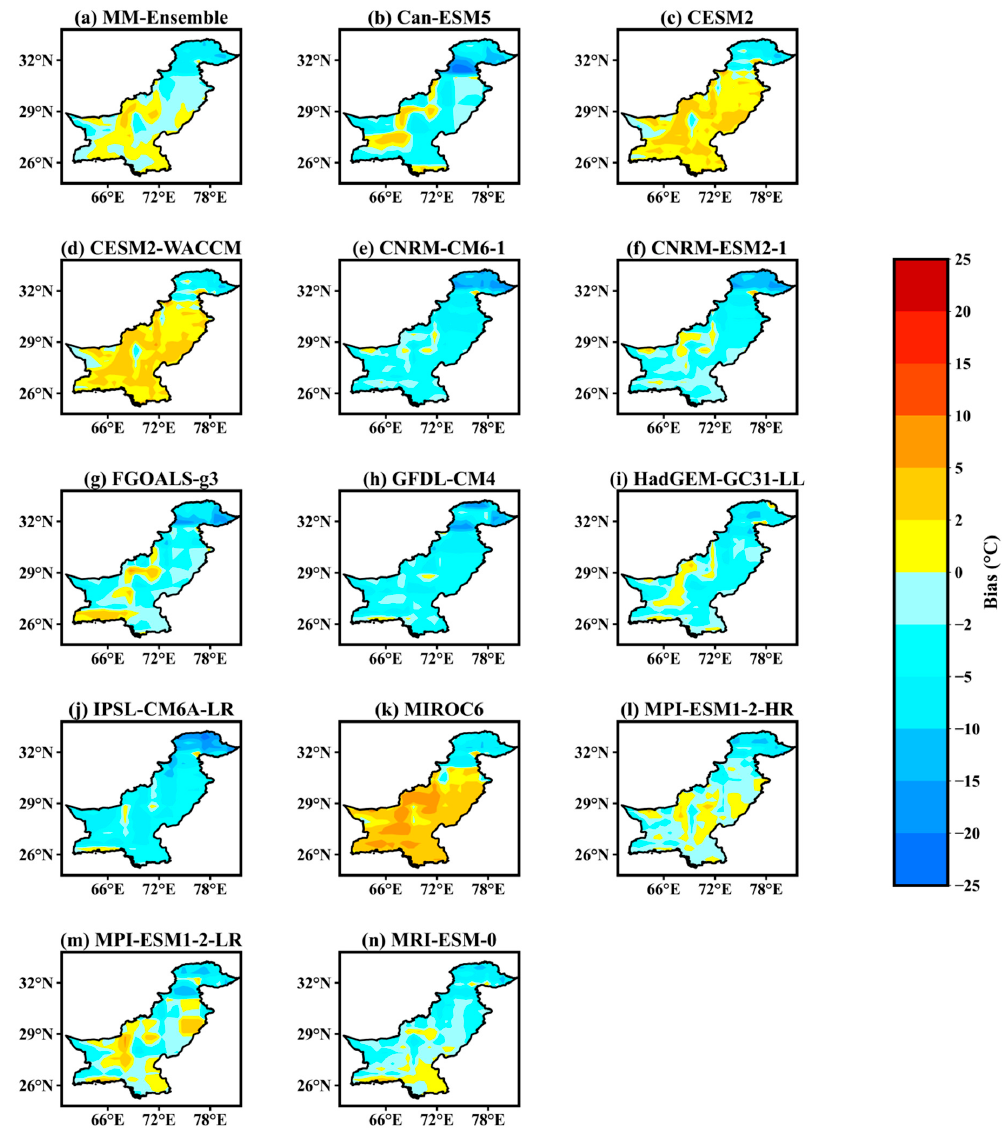
Figure 13. Same as Figure 10 but for winter (DJF) season bias.